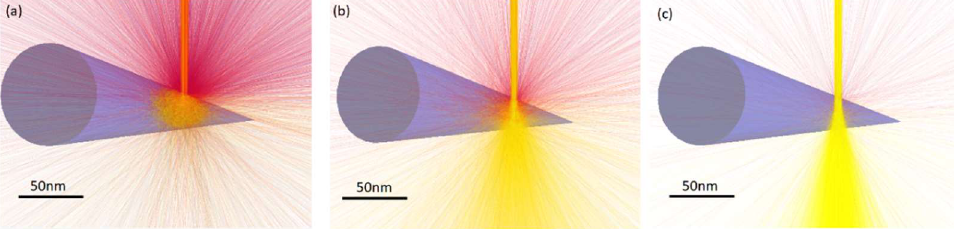
Figure 3. Simulated primary and secondary electron trajectories at different beam acceleration voltages upon incidence of a 5 nm beam on a horizontal Pt cone. ( a ) 3 keV; ( b ) 10 keV; ( c ) 30 keV. The best resolution is obtained at high acceleration voltages, since the low interaction between beam and cone leads to a higher spatial confinement of the electron irradiated region. All trajectories are colored by energy loss, increasing from yellow to red and blue.